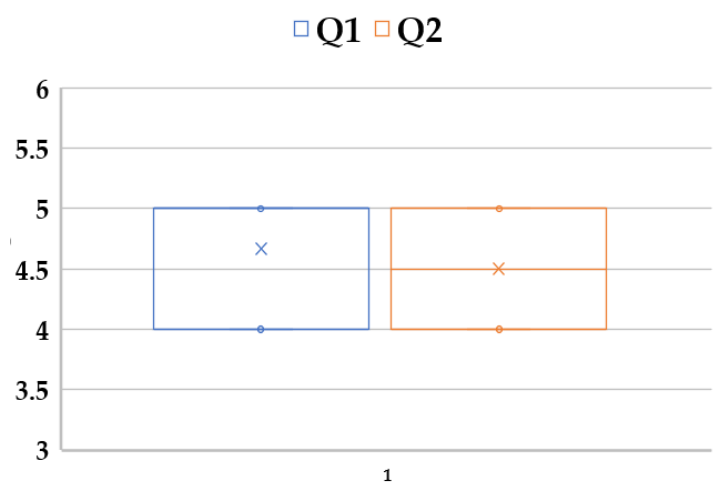
Figure 14. Distribution of teachers’ survey results.